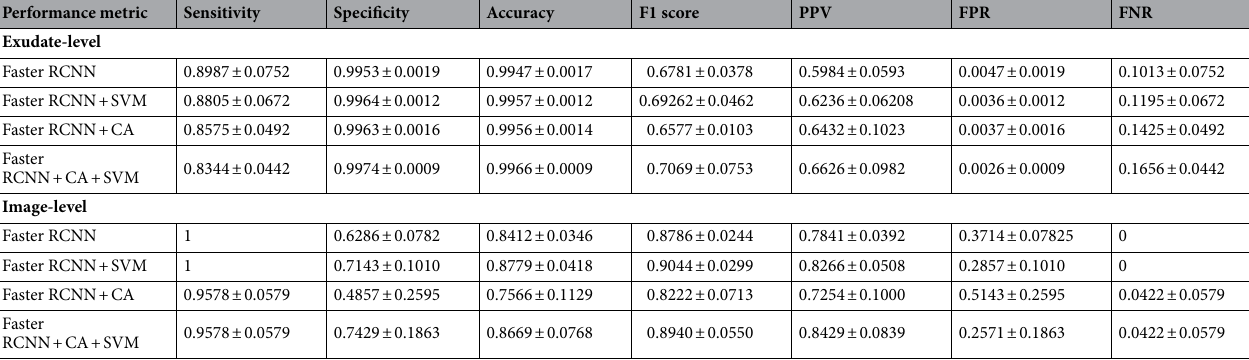
Table 1. Sensitivity, specificity, accuracy, F1 score, PPV, false positive rate (FPR) and false negative rate (FNR) at the exudate and image level of the proposed method are shown in the table. The first column shows the four variants of our method: faster R-CNN with or without contrast adjustment augmentation (CA) of the dataset and with or without SVM classifier pre-scanning. The values are represented as µ ± σ; µ represents the mean and σ represents the standard